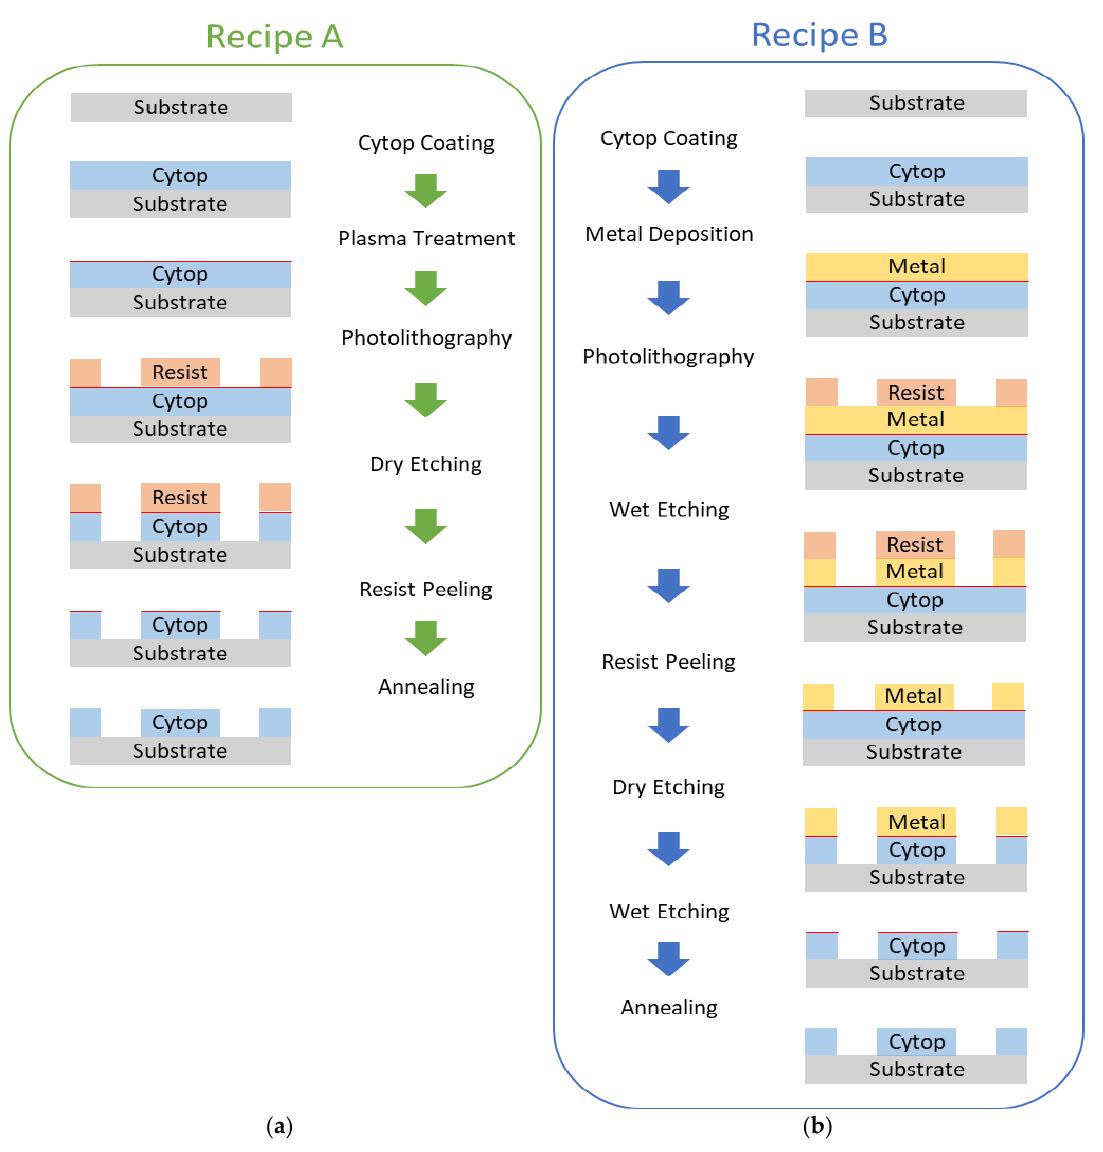
Figure 1. Process flow for the two developed recipes: ( a ) Recipe A includes 6 steps in total. The first step is “Cytop Coating”. Substrates are cleaned and Cytop films are prepared on top of the substrates by spin-coating. Then, “Plasma Treatment” is used to promote the adhesion of photoresists on the Cytop surface. The red line represents the damage to the Cytop surface during plasma treatment.